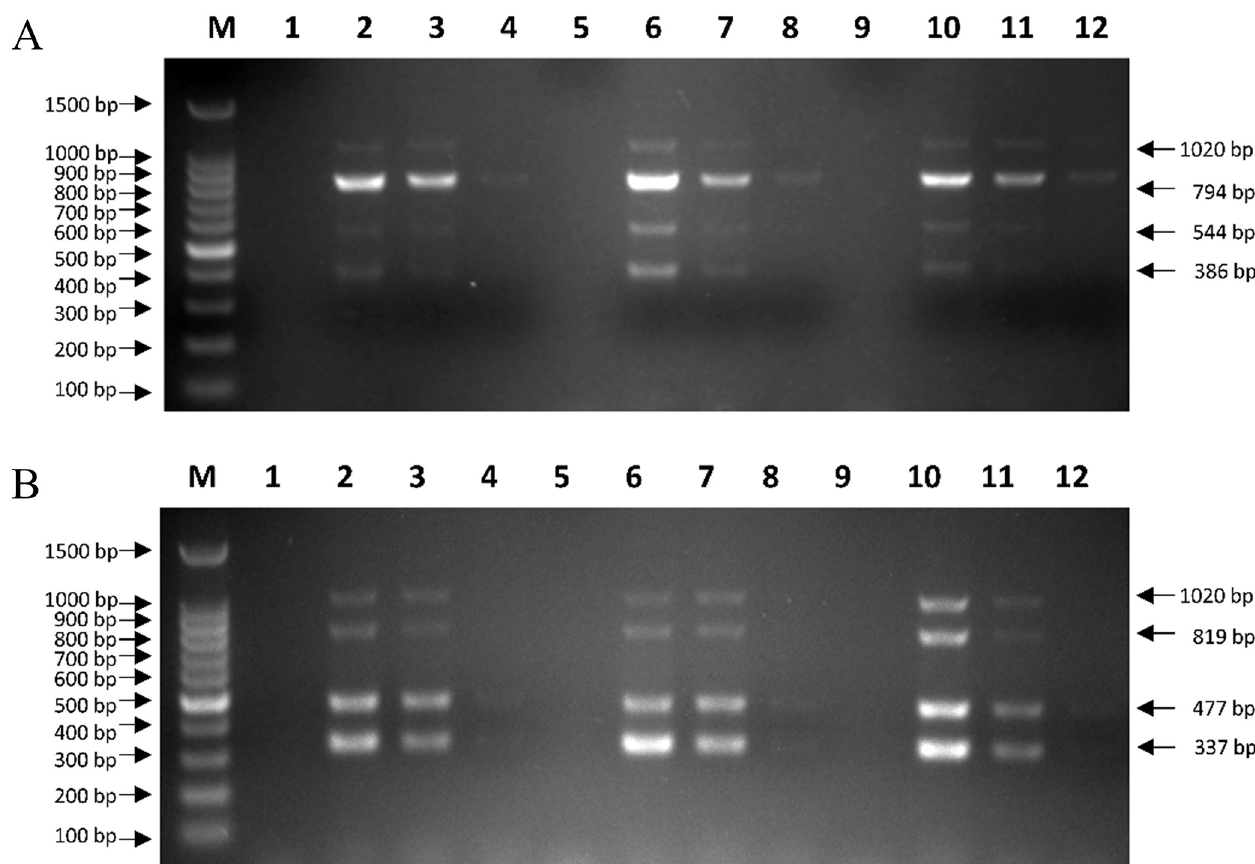
Fig 5. Reproducibility of the mPCR methods. Mixed CRV and CEV plasmids were diluted as templates from 1 × 10 5 to 1 × 10 3 copies/ μ l to amplify specific fragments by using three different PCR instruments at different times. (A) CRV: Lane M, 100 bp DNA ladder; Lanes 1, 5, and 9, negative controls for the three tests; Lanes 2~4, mPCR amplifying 1 × 10 5 copies/ μ l, 1 × 10 4 copies/ μ l, and 1 × 10 3 copies/ μ l CRV plasmids; Lanes 6~8, mPCR amplifying different dilutions of mixed plasmids a second time; Lanes 10~12, mPCR amplifying different dilutions of mixed plasmids a third time. (B) CEV: Lane M, 100 bp DNA ladder; Lanes 1, 5, and 9, negative controls for the three tests; Lanes 2~4, mPCR amplifying 1 × 10 5 copies/ μ l, 1 × 10 4 copies/ μ l, and 1 × 10 3 copies/ μ l CEV plasmids; Lanes 6~8, mPCR amplifying different dilutions of mixed plasmids a second time; Lanes 10~12, mPCR amplifying different dilutions of mixed plasmids a third